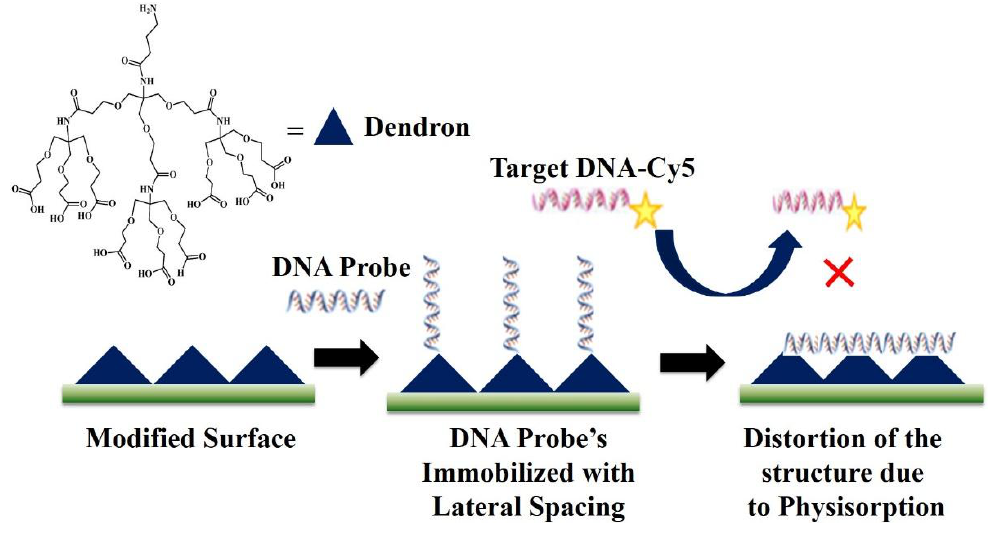
Figure 5. Use of nanocones (dendrons) for the covalent immobilization of